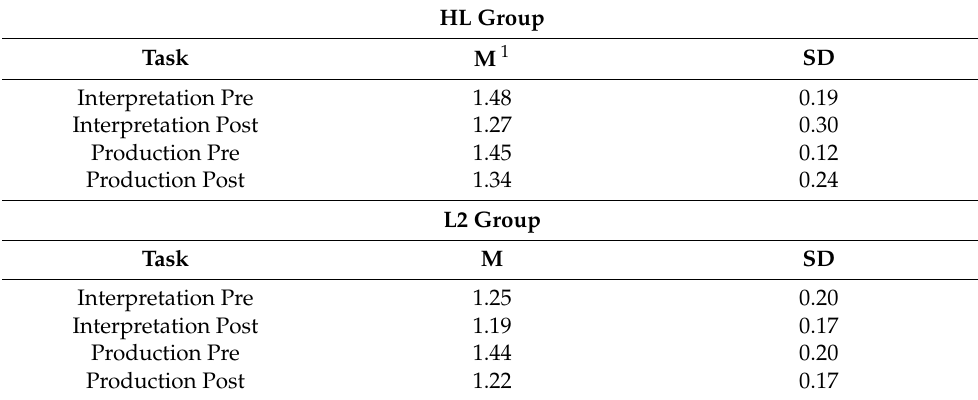
Table 2. Means and standard deviations of HL and L2 groups in the pre- and the post-tests. HL Group Task M 1 SD Interpretation Pre 1.48 0.19 Interpretation Post 1.27 0.30 Production